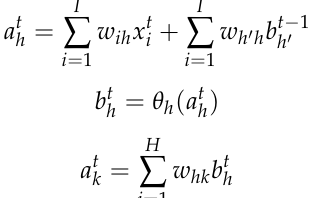
a represents the out- k t a is divided into h w represents the weight ' hh θ represents the activation h